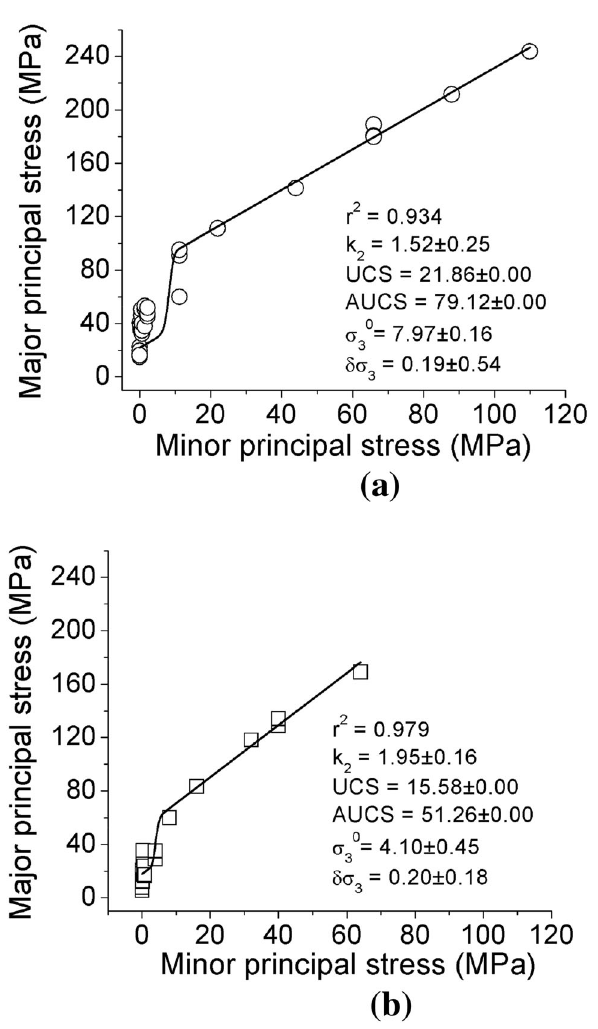
Fig. 4 Results of triaxial compressive tests ( a 0 (cid:3) included angle and b 30 (cid:3) included angle) fitted to s-shaped brittle failure criterion Table 2 Re-calculated spalling limits and the ratios of apparent UCS to UCS using the modified failure mechanism transition levels Cleat angle ( (cid:3)